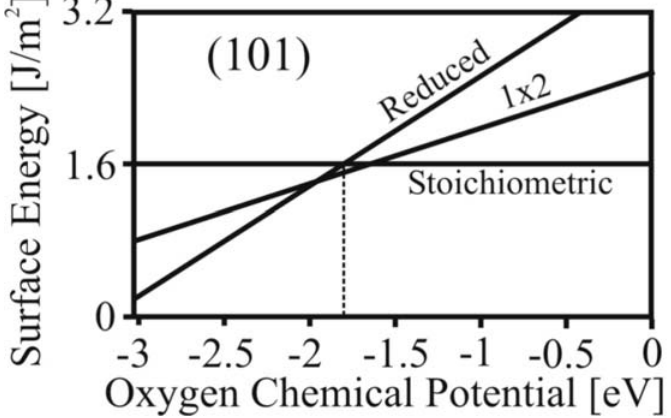
Figure 8 . Ab-initio thermodynamic calculations showing the surface energy as a function of